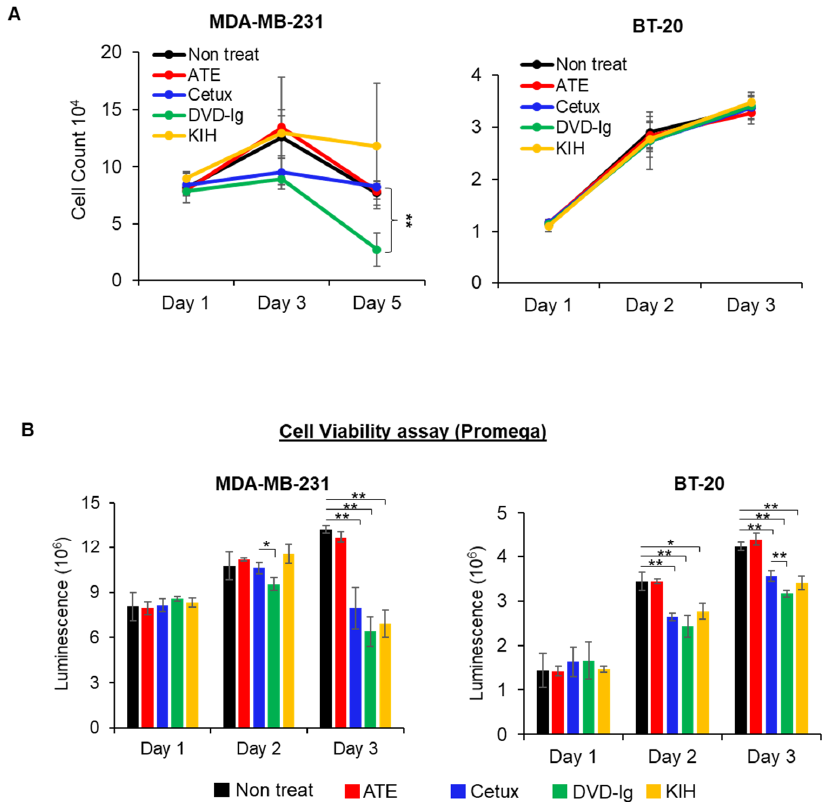
Figure 3. Antitumor potency of BsAbs in TNBC cells. ( A ) Cell proliferation assay was performed in MDA-MB-231 and BT-20 cells after treatment with anti-EGFR/PD-L1 BsAbs and parental mAbs. After treatments, live cells in non-treated and treatment groups were counted using trypan blue exclusion method at indicated timepoints. ( B ) CellTiter-Glo luminescent cell viability assay was per- formed in MDA-MB-231 and BT-20 cells. For this experiment, 10,000 cells were seeded in white- bottom 96-well plates and allowed to adhere overnight. After treatments with mAbs and BsAbs (20 μg/mL for Cetux, ATE and DVD-Ig, and 40 μg/mL for KIH format of BsAb) for indicated time, CellTiter-Glo reagent was added into the plates to measure luminescence using the Promega Glo- max Discover plate reader. Both assays were performed in biological triplicates, and data are repre- sentative of two or more experiments. The differences between two groups were considered statis- tically significant when p < 0.05 (*, p < 0.05; **, p < 0.01). 3.4. PD-1/PD-L1-Blocking Activity The PD-1/PD-L1 blockade bioassay assesses the mechanism of action (MOA) of anti- body therapeutics that are designed to block PD-1/PD-L1 interaction [26]. The PD-1/PD- L1-blocking activity of anti-EGFR/PD-L1 BsAbs was assessed using a standard PD-1/PD- L1 blockade assay in which CHO-K1 cells were engineered to express human PD-L1 and cell surface protein designed to activate cognate TCRs in an antigen-independent manner. Data from the PD-1/PD-L1 blockade assay showed that both formats of anti-EGFR/PD-L1 BsAbs retained their ability to block PD-1/PD-L1 interaction and have a comparable block- ing profile to ATE (Figure 4). As expected, cetuximab did not show any PD-1/PD-L1- blocking activity. These data indicate that both formats of anti-EGFR/PD-L1 BsAbs can disrupt the engagement of PD-1 to its ligand PD-L1 and thereby promote TCR signaling, transcriptional activation and cytokine production.